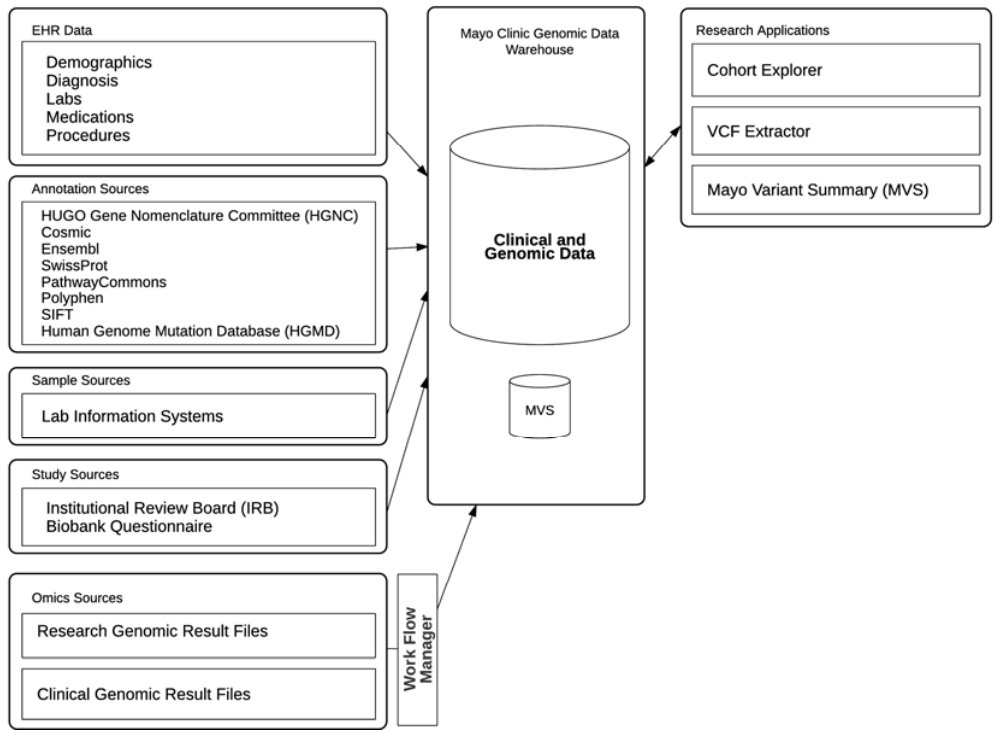
Figure 1. Mayo Clinic genomic data warehouse architecture. EHR: electronic health records VCF: Variant Call Format2.2. Project Timeline J. Pers. Med. 2017 , 7 , 7